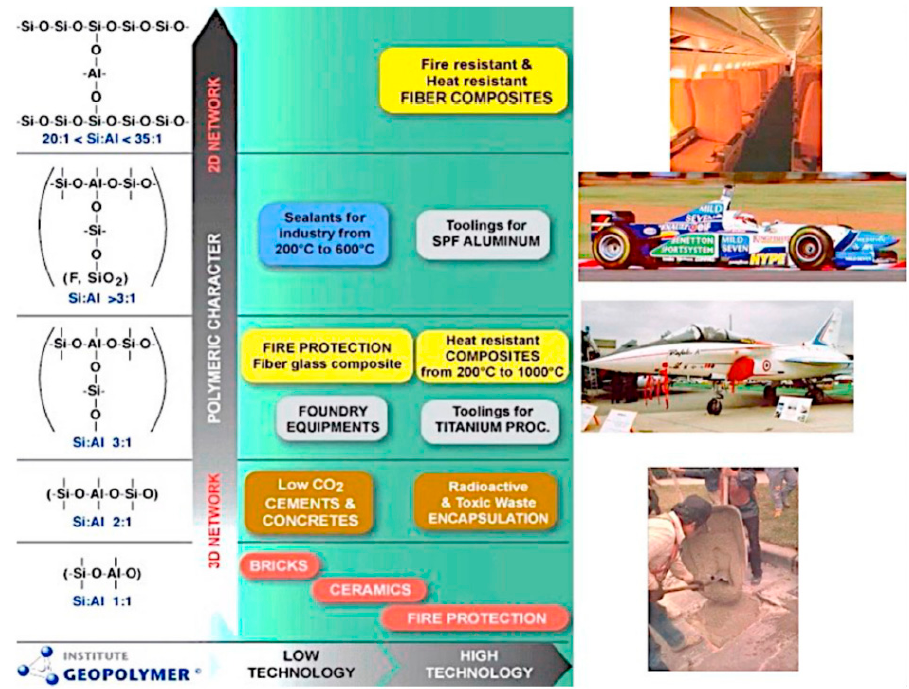
Figure 5. Applications of geopolymers with respect to polymeric chain [45].